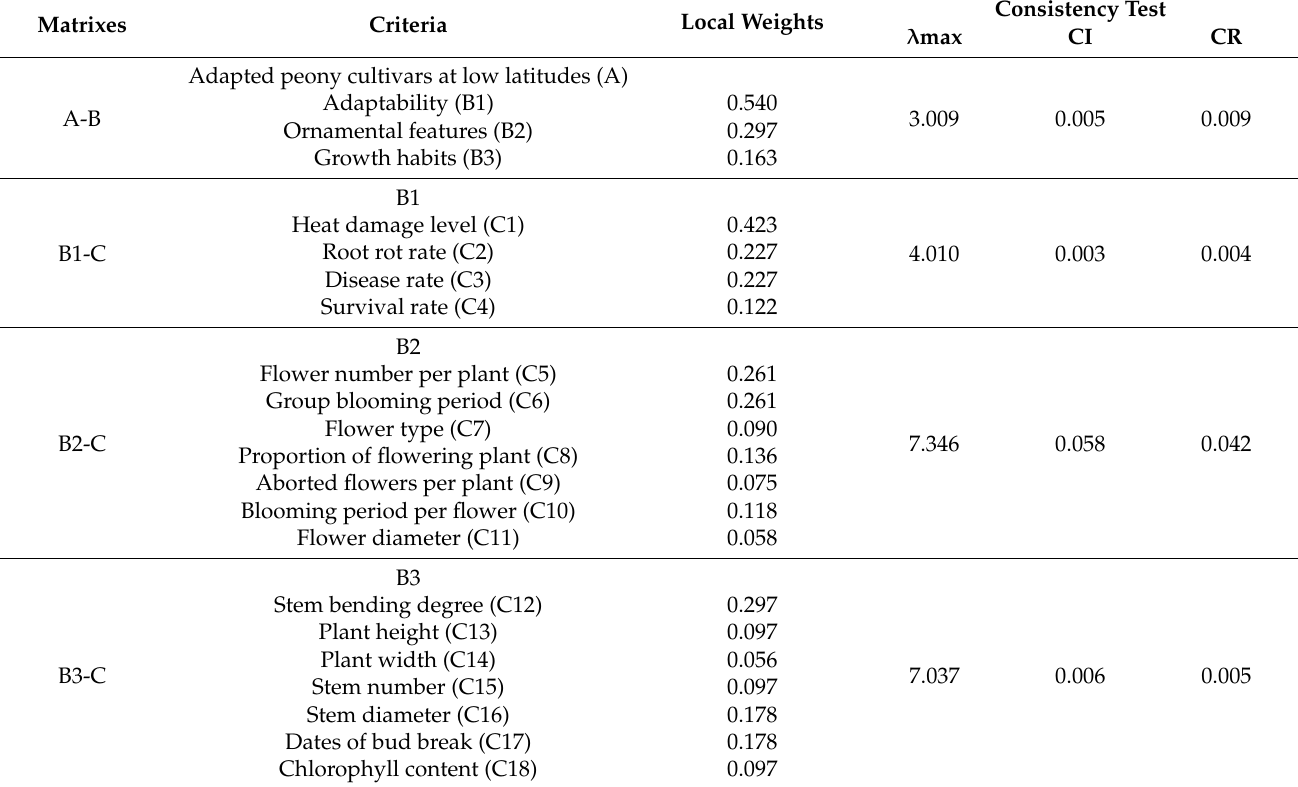
Table 1. The local weights of criteria and consistency test of the pairwise comparison